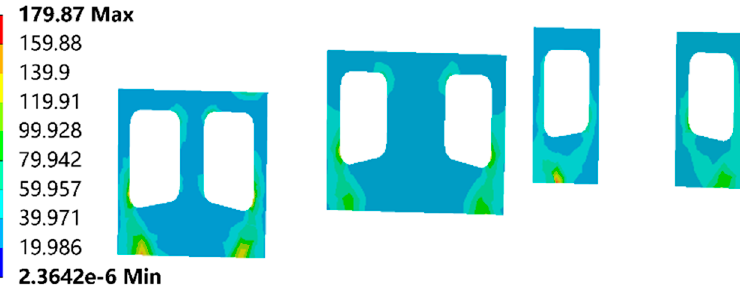
Figure 18. Von Mises stress in the suspender-anchored diaphragms of arch rib bifurcation segment under constant load (unit: MPa). under constant load (unit: